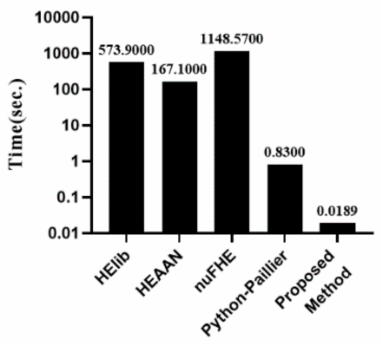
Figure 11. Performance comparison of search operations.